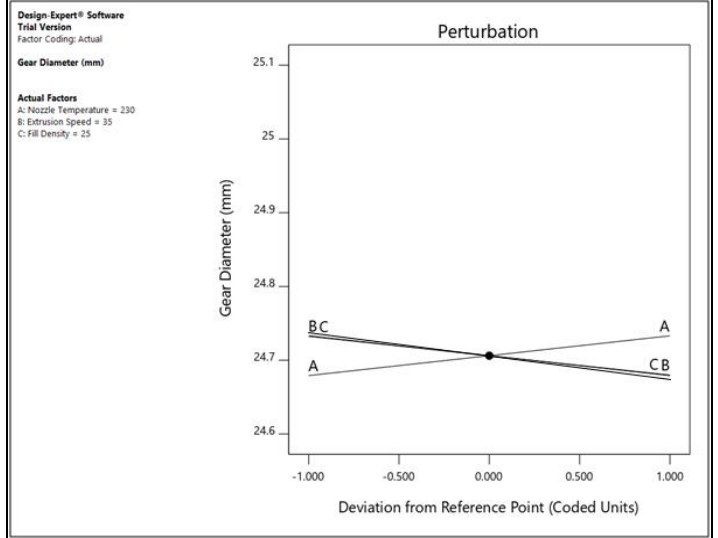
Fig. 3. Perturbation plot of factors in measuring the dimensional